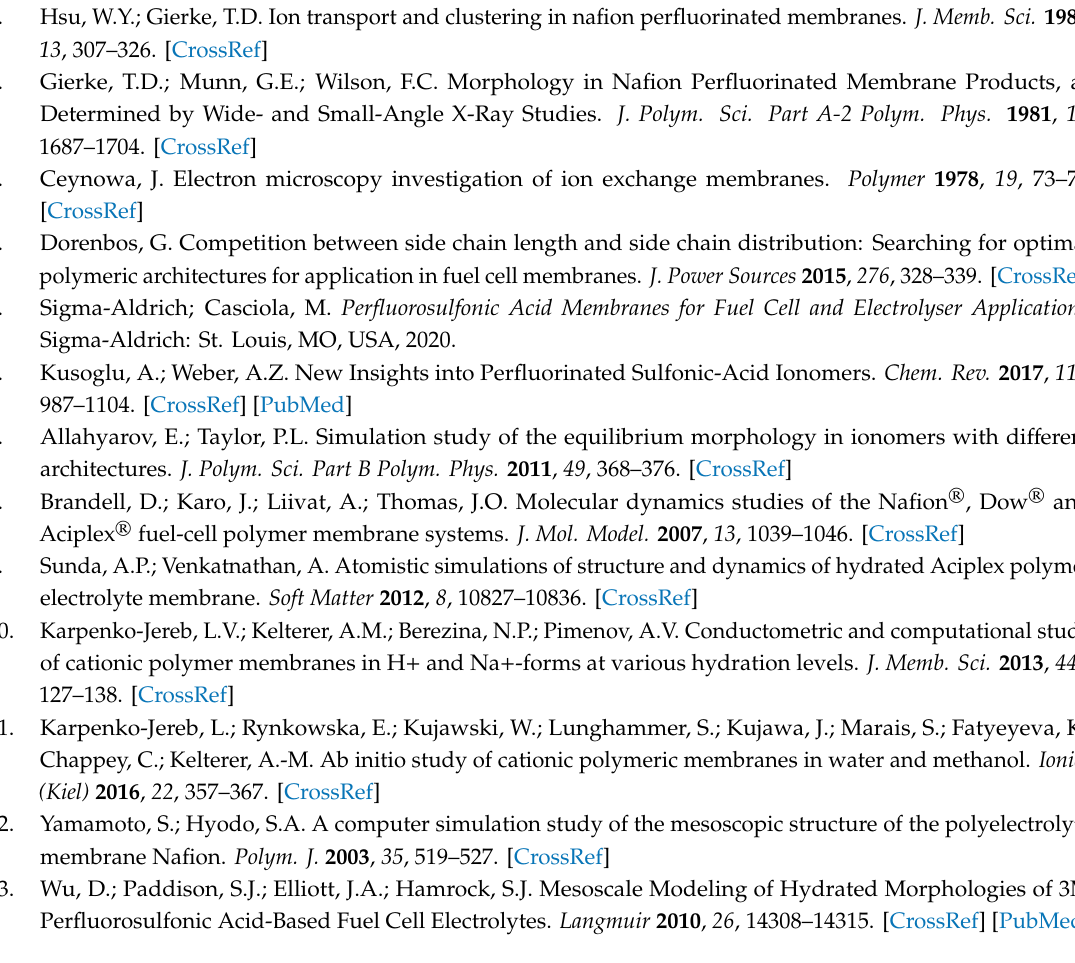
Figure S1: Comparison of radius of gyration ( R g ) for the dry Dow, Nafion and Aciplex membranes, Figure S2: Comparison of radial distribution function (RDF) for the hydrated PEMs for (a) C–C (b) W–W at 2 × 10 6 time steps, Figure S3: Comparison of the time evolution of the hydrophilic bead cluster count / number of clusters and average cluster size for di ff erent side-chain length PEMs in three di ff erent layers at distances ranging from (a),(b) 5–15 DPD units (c),(d) 15–25 DPD units, (e),(f) 25–35 DPD units from the bottom Z